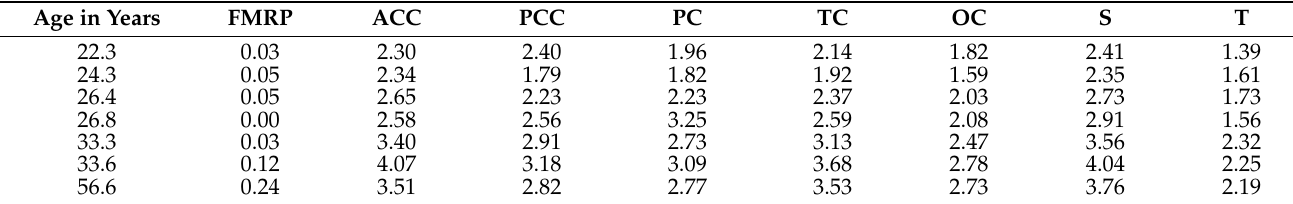
Table 2. Fragile X Mental Retardation Protein (FMRP) in nanogram per microgram total protein and ratios of 3-[ 18 F]fluoro-5-(2-pyridinylethynyl)benzonitrile ([ 18 F]FPEB) uptake in the regions of interest (ROIs) to uptake in the cerebellum of men with the full mutation (FM) or an allele size mosaicism (FXS-M) (age = 56.6) of fragile X syndrome (FXS) [62].